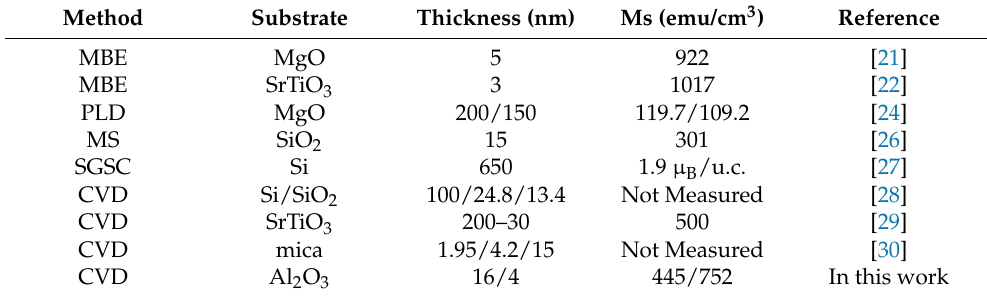
Table 1. Saturation magnetization and thickness of Fe 3 O 4 films synthesized by different methods.